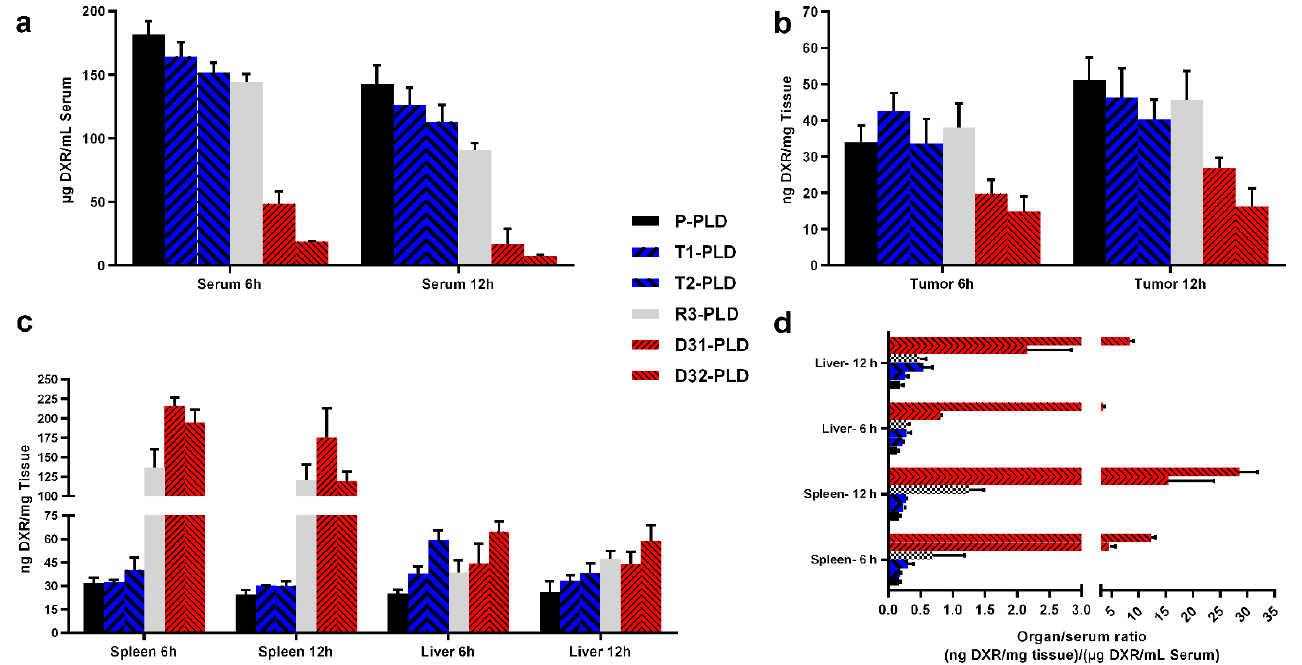
Figure 8. Biodistribution of PLDs at different time points after a single IV injection of 15 mg/kg of liposomal DXR in the serum ( a ), tumor ( b ), and spleen and liver ( c ) of C57 mice bearing B16 tumors. Panel d represents the affinity of different liposomes to spleen and liver at different time points. Data represent mean ± SD ( n = 4).